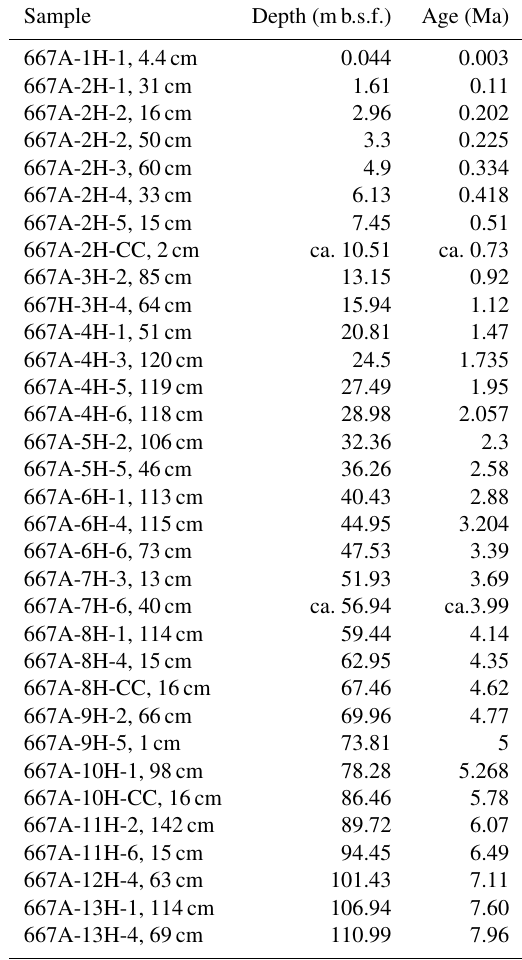
Table 1. Studied samples, their depths in metres below seafloor (mb.s.f.) and age (Ma; Neptune model 0667A.loc95 (using magne- tostratigraphic, planktonic foraminiferal and calcareous nannofossil data)) of Hole 667A, following the age depth plot of Fig. 2. Sample Depth